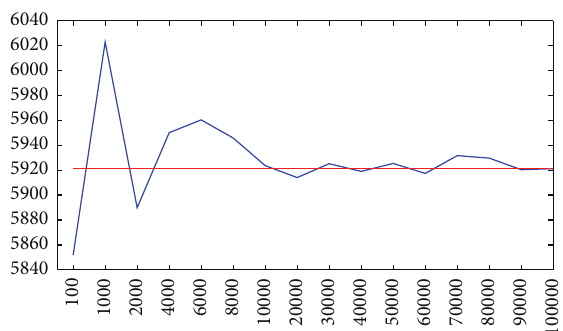
Figure 8: Monthly evolution of the standardized relative error (2013). Table 4: Option parameters.